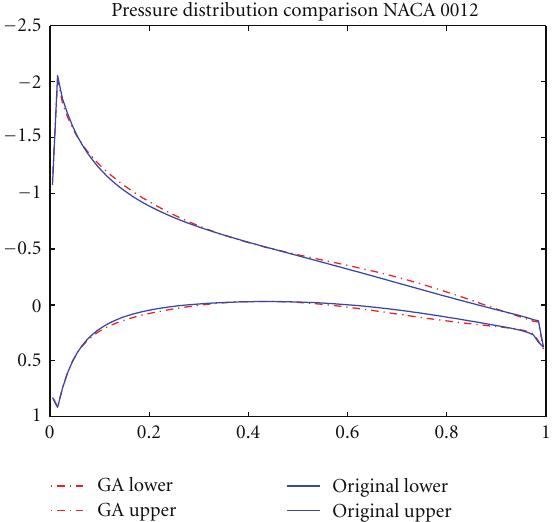
Figure 4: Comparison of pressure distribution over the surface of original NACA 0012 airfoil and optimized airfoil using SA.